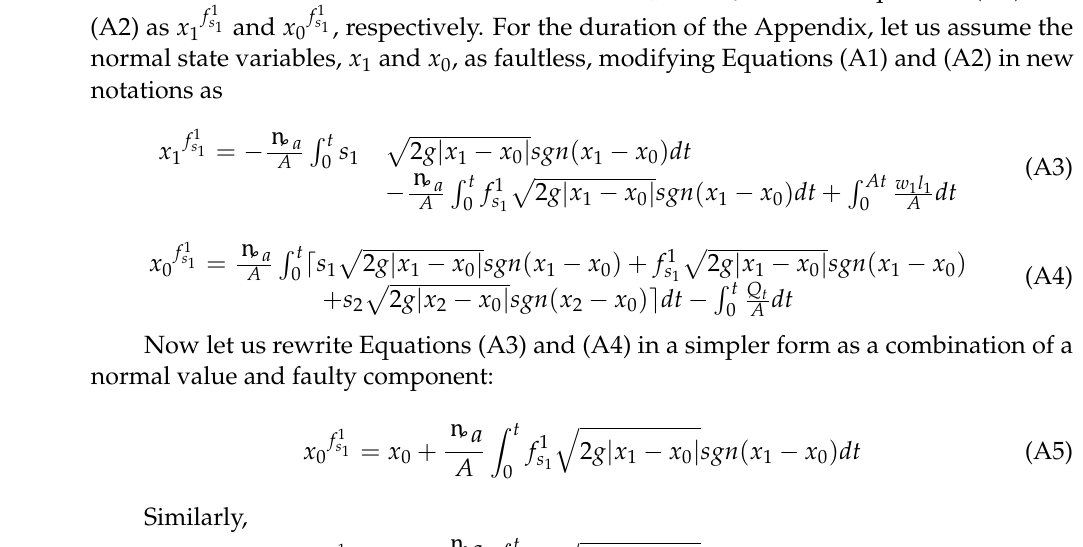
Figure 1. Three-pond hydraulic system.